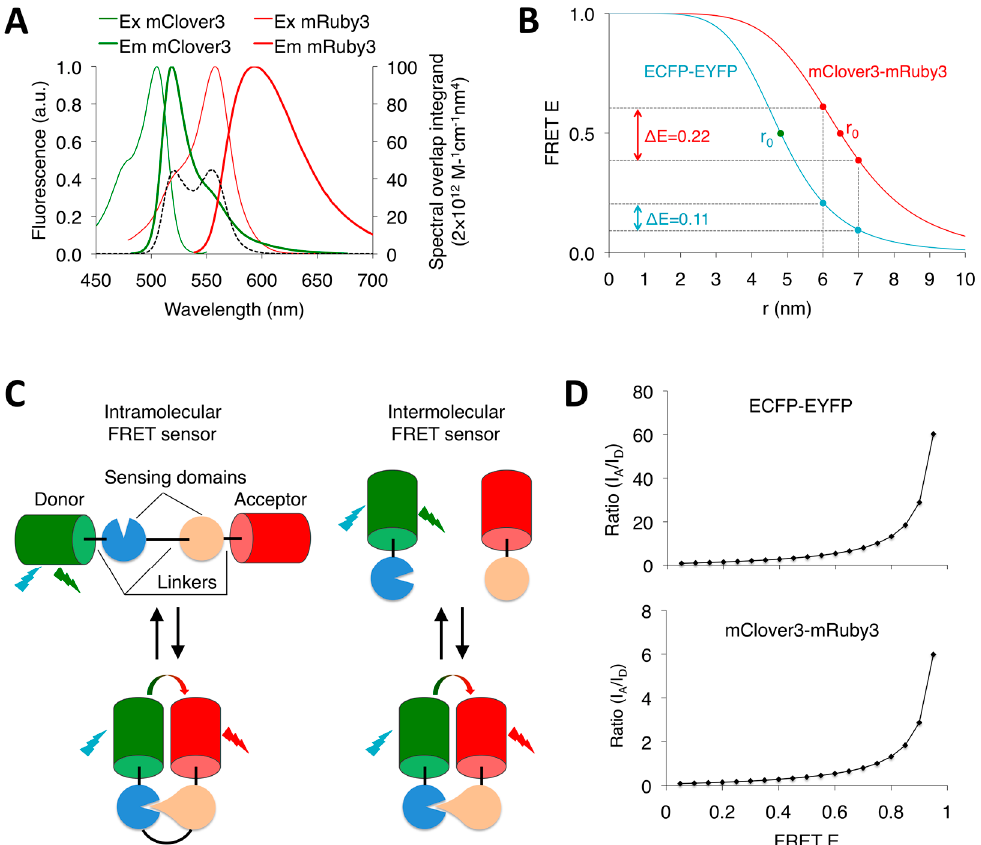
Figure 1. The principle of fluorescence resonance energy transfer (FRET). ( A ) Spectral overlap between mClover3 and mRuby3. The spectral overlap integrand (a product of f d ( λ ), ε A and λ 4 in the Equation (2)) is indicated by the black dashed line; ( B ) FRET efficiency (FRET E) versus distance. The FRET E varies with the sixth power of distance between donor and acceptor. The Förster radius (r 0 ) is the distance at which 50% FRET occurs. Compared to ECFP-EYFP, mClover3-mRuby3 exhibits a larger FRET E change because of the larger r 0 at which the given FRET biosensor operates; ( C ) Two types of FRET biosensors: intramolecular and intermolecular FRET biosensors. The sensing domains undergo conformational changes (intramolecular) or inter-domain interactions upon biochemical changes, leading to the change in FRET E; ( D ) The relationship between the intensity ratio of acceptor to donor (I A /I D ) and FRET E. The ratio of peaks of the emission spectrum acquired by a sensitivity-normalized spectrum-scanning device is non-linearly related to the actual FRET E. However, it is important to note that ratios taken through filter cubes and cameras are not equivalent to ratios derived from a spectrum-scanning device, as filter cubes pass different amounts of light depending on the transmission spectra and cameras exhibit wavelength-dependent sensitivity.